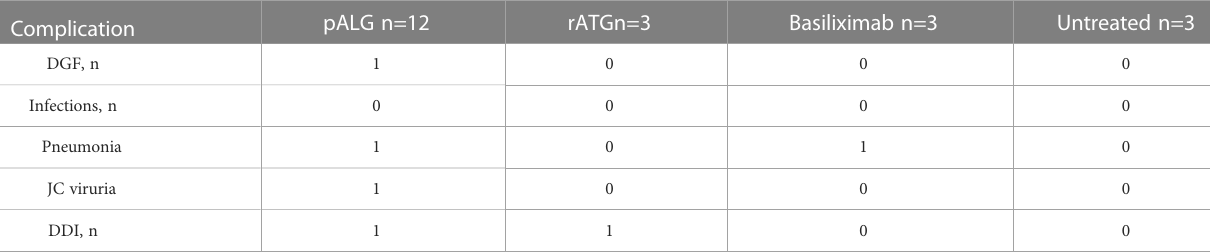
TABLE 2 Complications after kidney